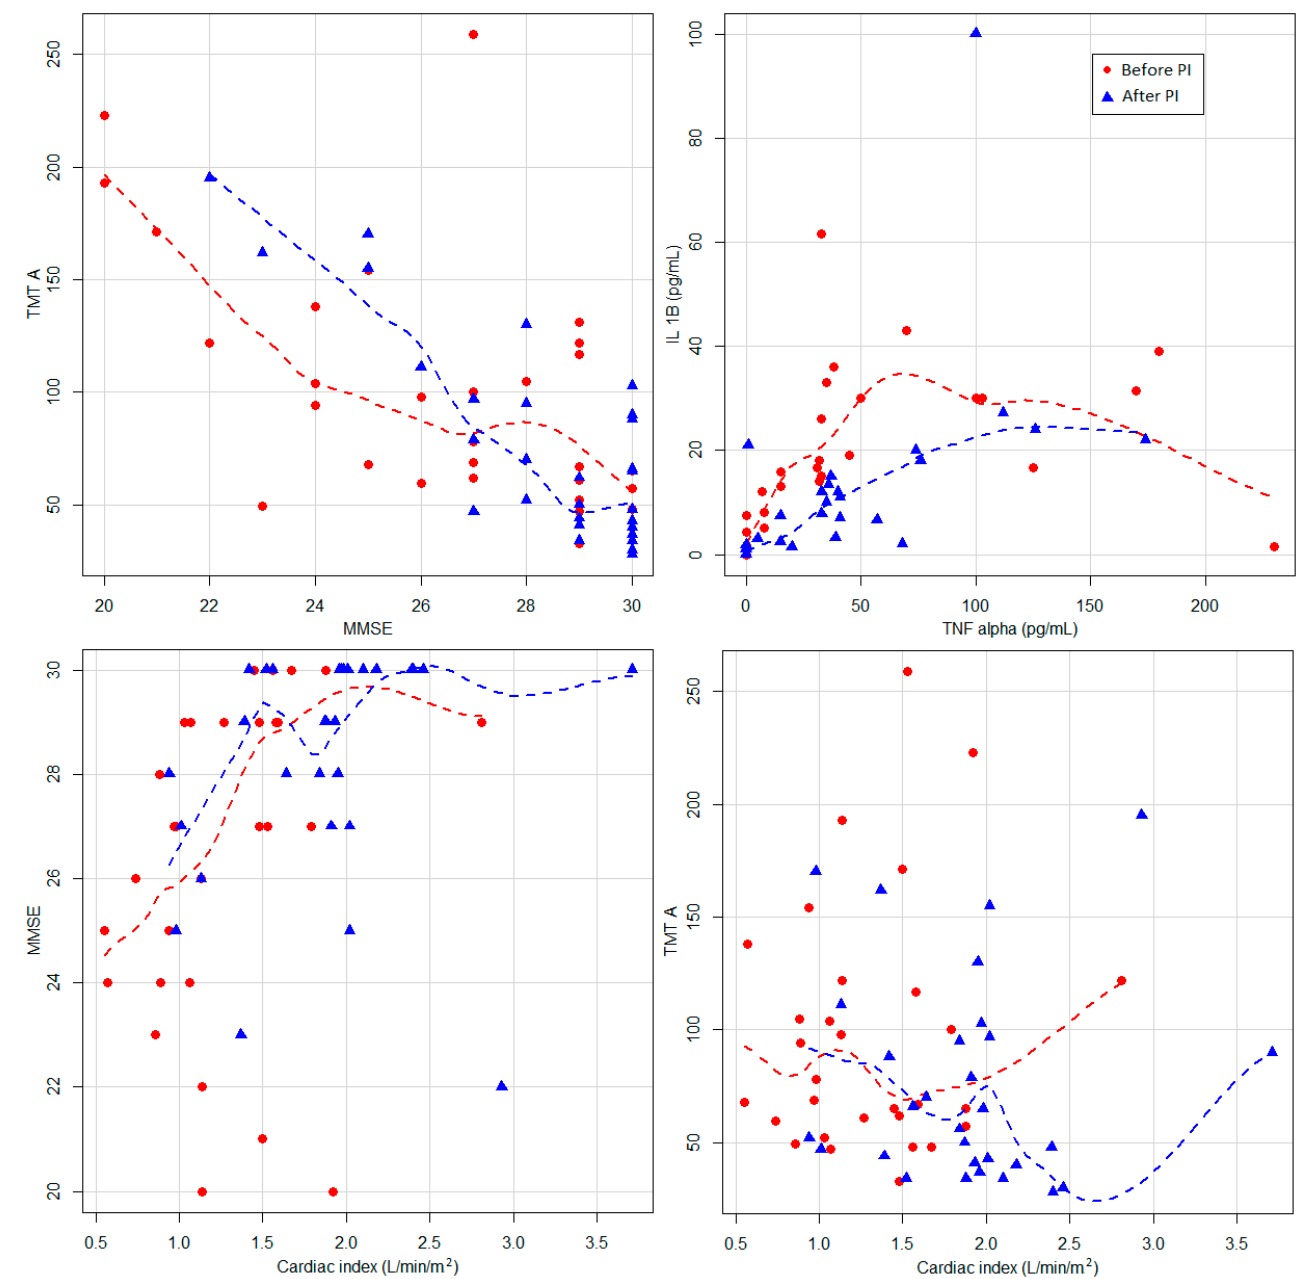
Figure 1 .Relation between cardiac index and MMSE and TMT A. The lines represent locally weighted scatterplot smoothing curves. MMSE—Mini Mental State Examination; TMT A—Trail Making Test A; PI—pacemaker implantation; TNF alpha—Tumor Necrosis Factor Alpha; IL-1 β —Interleukin 1 Beta.